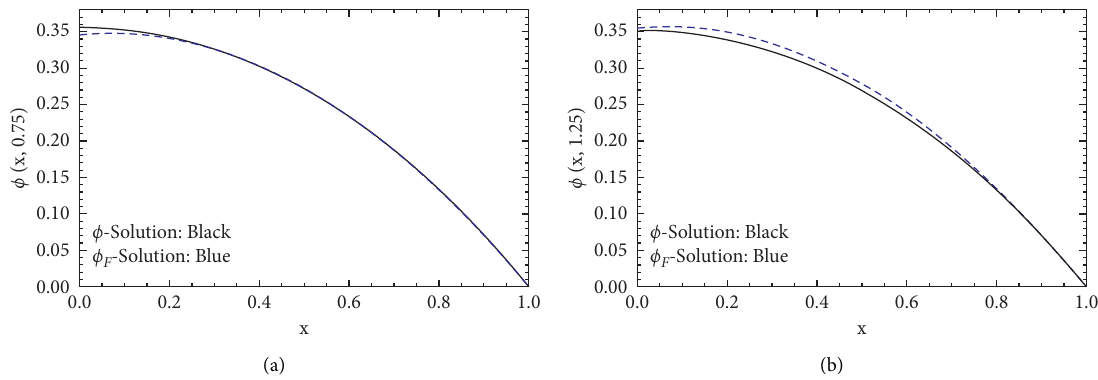
Figure 1: The approximate and exact solutions at F � 4 via T